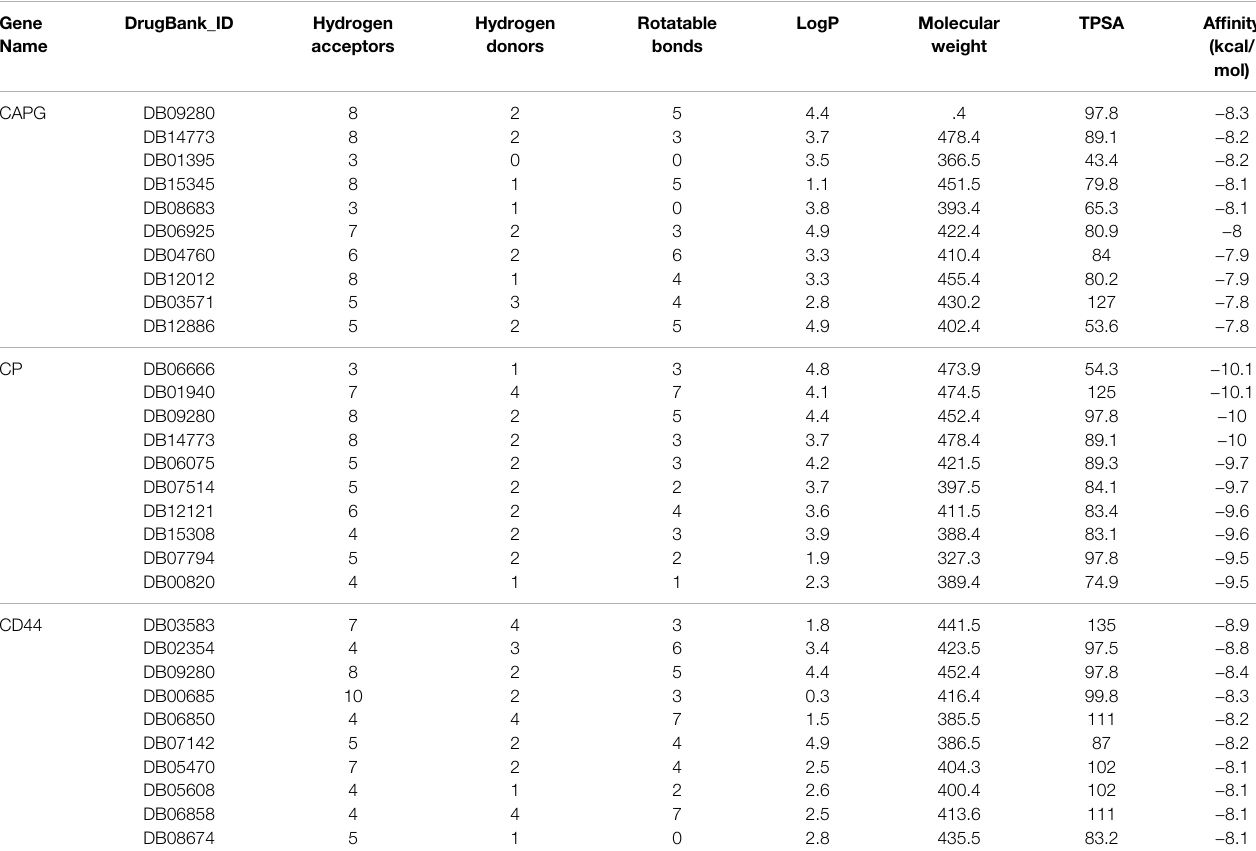
TABLE 1 | Top 10 compounds with the best docking score to CAPG, CP and